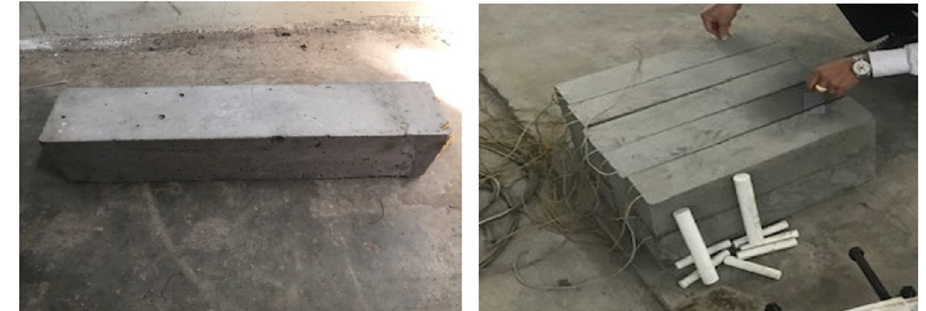
Figure 2: Test beams after